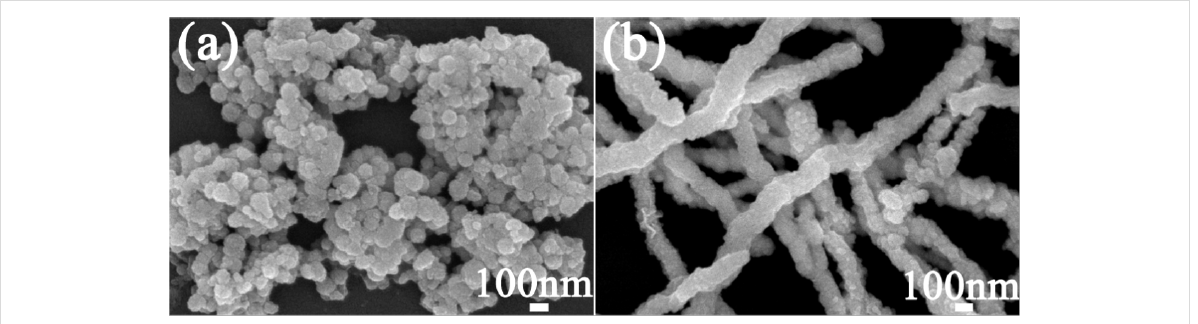
Figure 1: SEM images of bimetallic Co–Cu nanowires (a) without an external magnetic field and (b) with an external magnetic